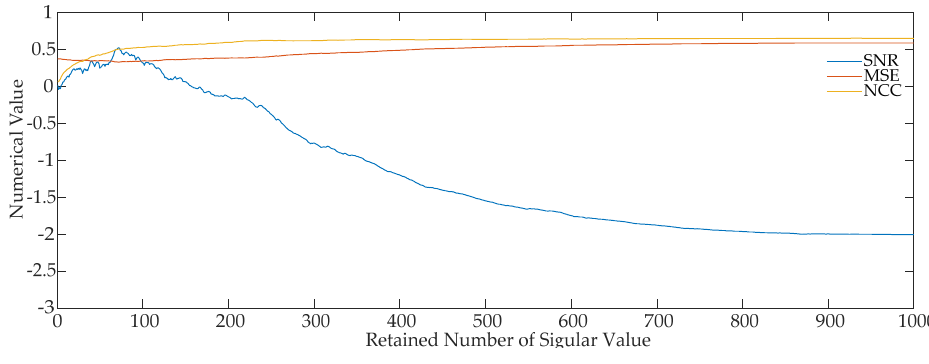
Figure 6. Distributions of evaluation indices.